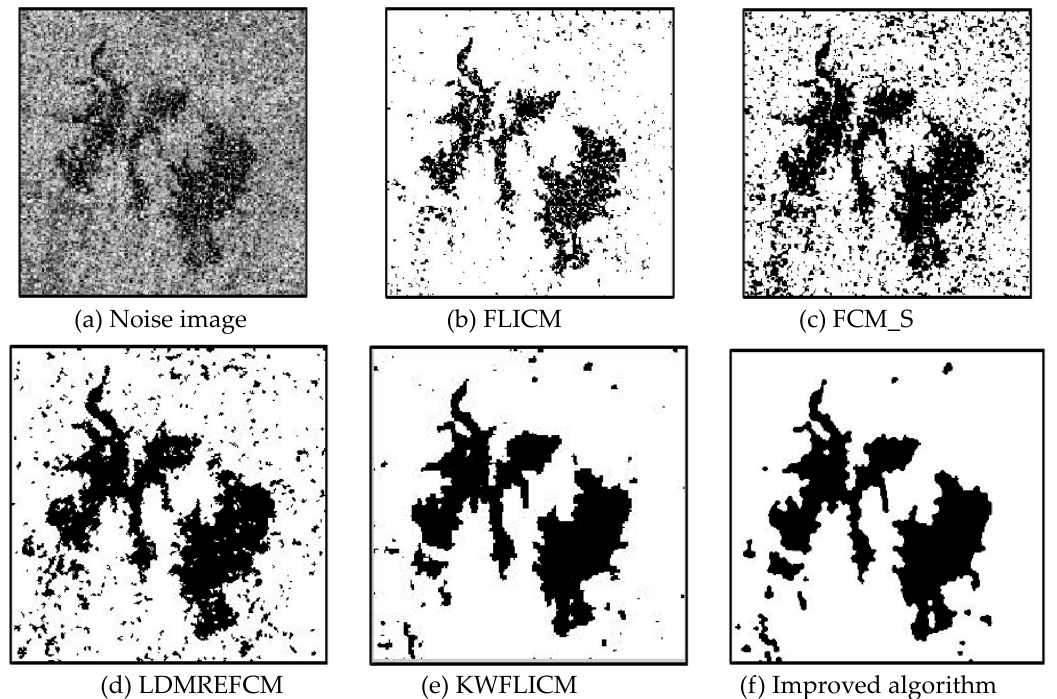
Figure 7. Remote sensing image 4 disturbed using salt-and-pepper noise ( a ) and the segmentation results ( b – f ).